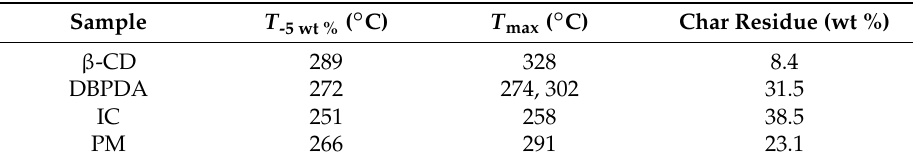
Table 2. TGA Data of β -CD, DBPDA, IC and PM under N 2.